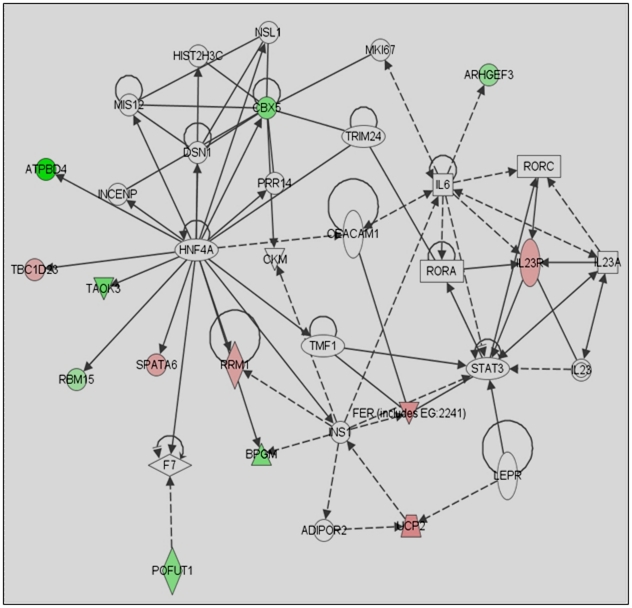
Ingenuity Pathway Analysis (IPA) of cell growth related genes in p85α−/− MCp's in response to SCF stimulation.Altered genes in p85α−/− cells after SCF stimulation were analyzed by IPA software to analyze their closely associated gene network. Significantly altered cell growth related genes in p85α−/− MCp's in response to SCF stimulation were indicated.